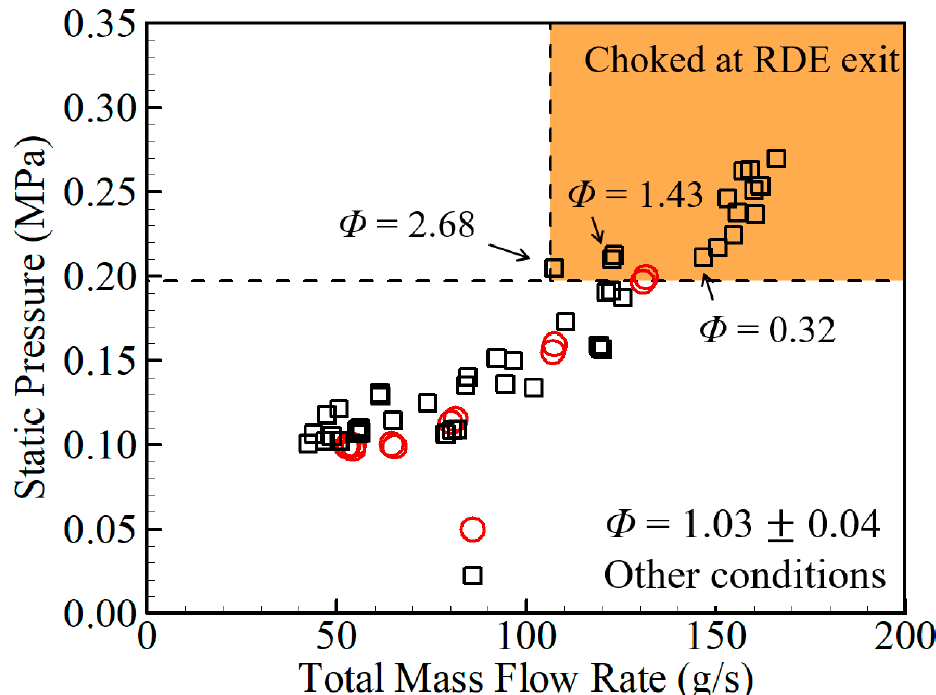
Figure 10. Time-averaged static pressure in the combustion channel.